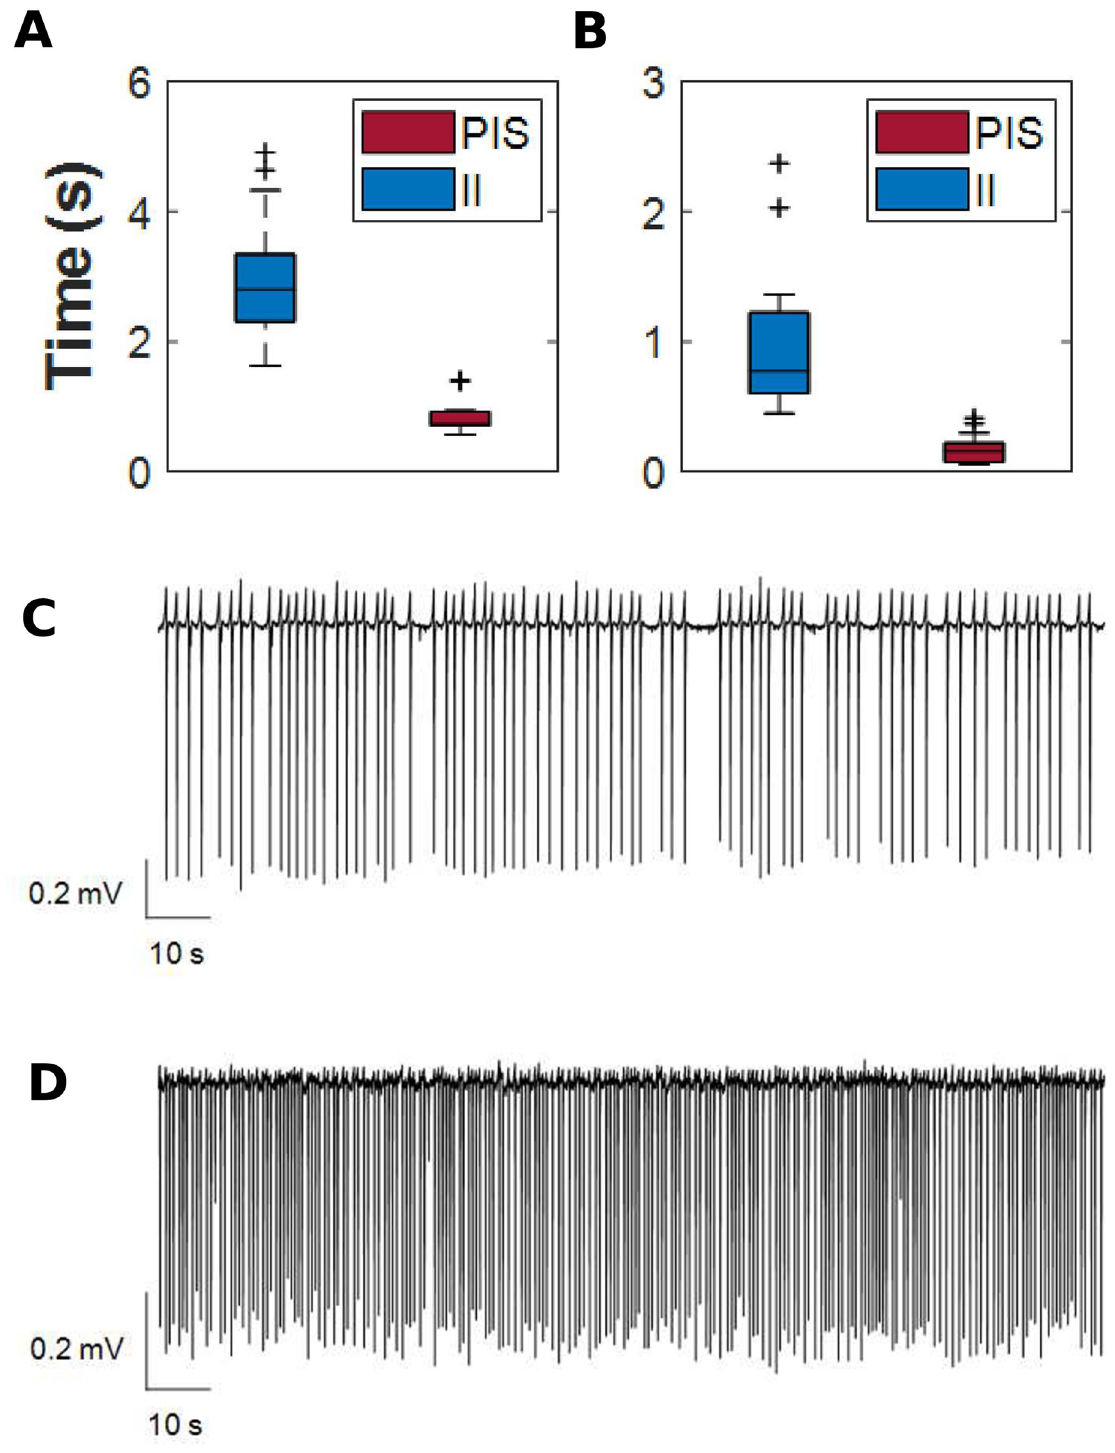
Fig 3. Interspike intervals for II and PIS pattern. (A) Interspike intervals (in seconds) distribution from all electrophysiological signals evaluated, independently of patient in which were recorded. The shaded region in gray represents the confidence limits for PIS epileptiform activity. Distributions of (B) means and (C) standard deviations of interspike intervals. The symbol “+” in all boxplots represents outlier values. Electrophysiological signals recorded in dentate gyrus of (D) interictal-like events and (E) periodic ictal spiking.